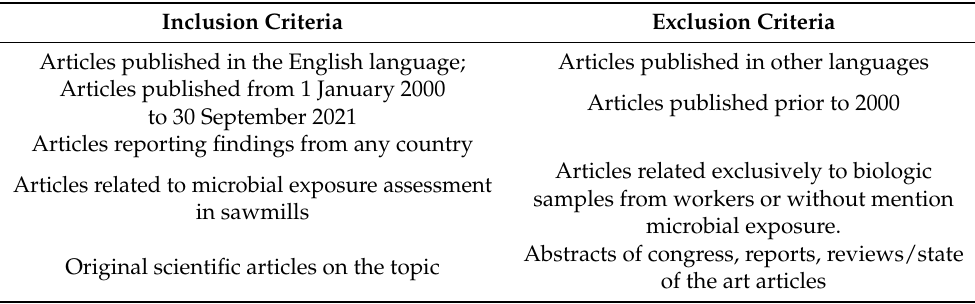
Table 1. Inclusion and exclusion criteria in the articles selected. Inclusion